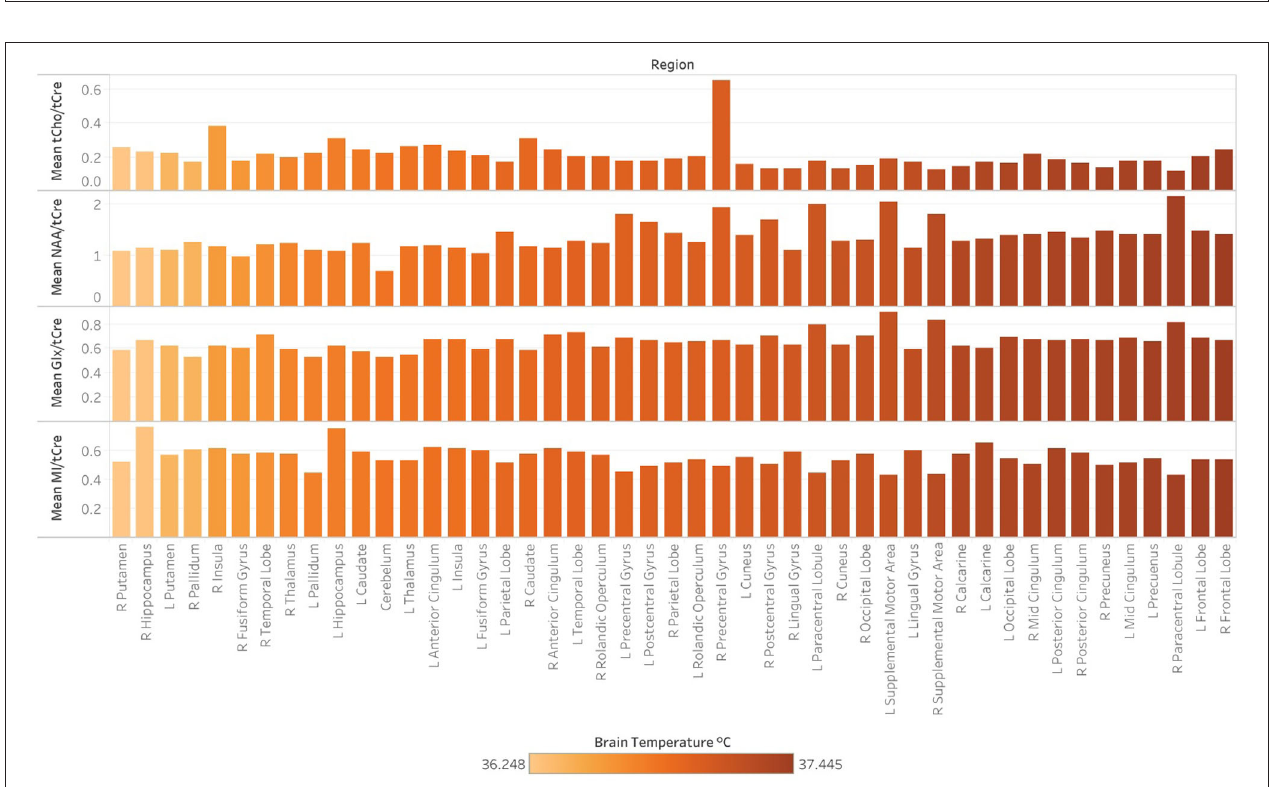
FIGURE 5 | smoothed volumes, 60 pairs) for 18 participants. Mean T CRE and CBF maps were resliced and co-registered to Montreal Neurological Institute template space with the Statistical Parametric Mapping (SPM12) toolbox running in MatLab R2019b. All data are visualized for axial view of the same slice ( z = 8; L, left; R; right). The T CRE color scale ranges from 36.0 to 39 ◦ C, with dark to light blue coloring indicating T CRE values within the typical range. The majority of voxels demonstrate T CRE < 37.5 ◦ C, with a mean of 37.0 ◦ C for time1 and 37.4 ◦ C for time2 (global mean of 37.2 ◦ C). As demonstrated by the time1 and time2 maps and the global COVrep of 1.92%, there was a minimal variation in participants’ data from time1 to time2. For some participants’ data, brain regions were excluded from analysis due to technical reasons; these areas are represented by regions where the template brain is exposed. Each participant’s mean CBF maps for time1 and time 2 are visualized alongside T CRE maps; as with T CRE mean CBF varies little from time1 to time2. Spatial T CRE variations did not vary as a function of cerebral perfusion as indicated by mean CBF. The open-source software MRIcroGL (McCausland Center for Brain Imaging, University of South Carolina; https://www.mccauslandcenter. sc.edu/mricrogl/) was used to overlay mean T CRE and CBF maps on the MNI single-participant template for 3D renderings of participant data. The figure was created using BioRender.